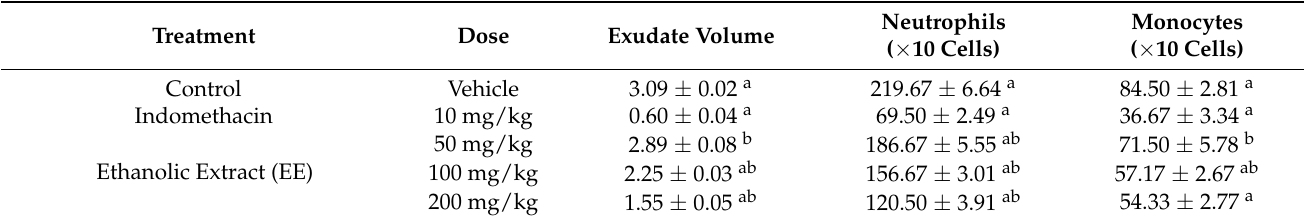
Table 10. Effect of EE, CE and DCME of N. triquetra on exudate volume and neutrophil and monocyte count in carrageenan- induced air-pouch